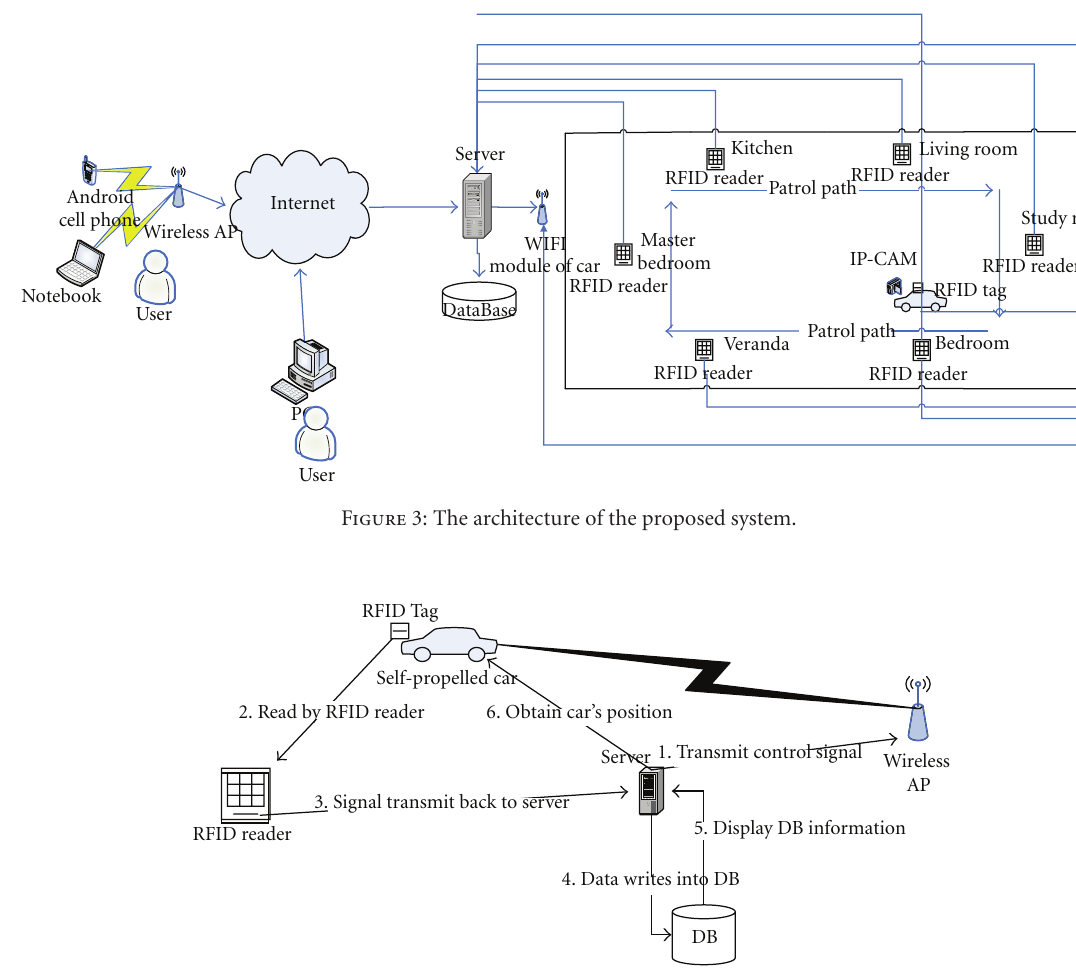
Figure 4: RFID position detection